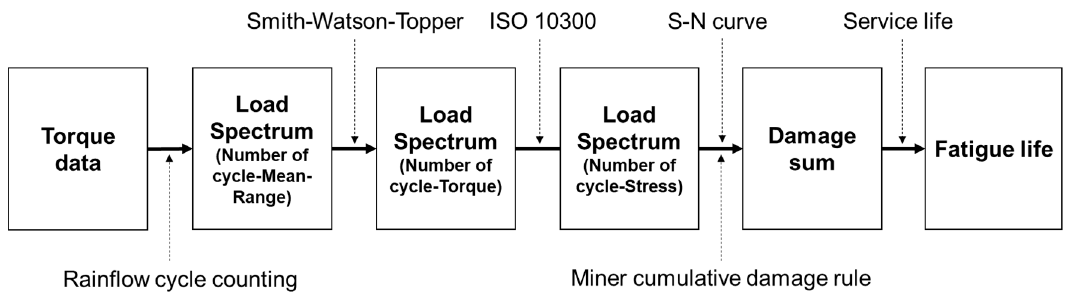
Figure 4. Procedures of fatigue life evaluation for tractor transmission spiral bevel gear using field torque data.